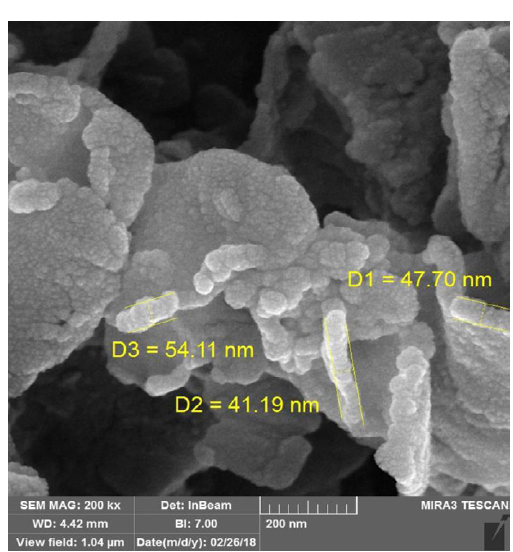
Fig.3. FESEM of Au nanorods /g-C 3 N 4 nanocomposite